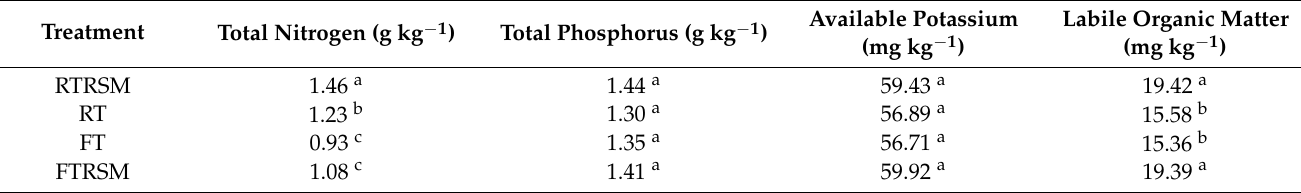
Table 1. Total nitrogen, phosphorus, available potassium and labile organic matter contents of soil under different treatments. Treatment